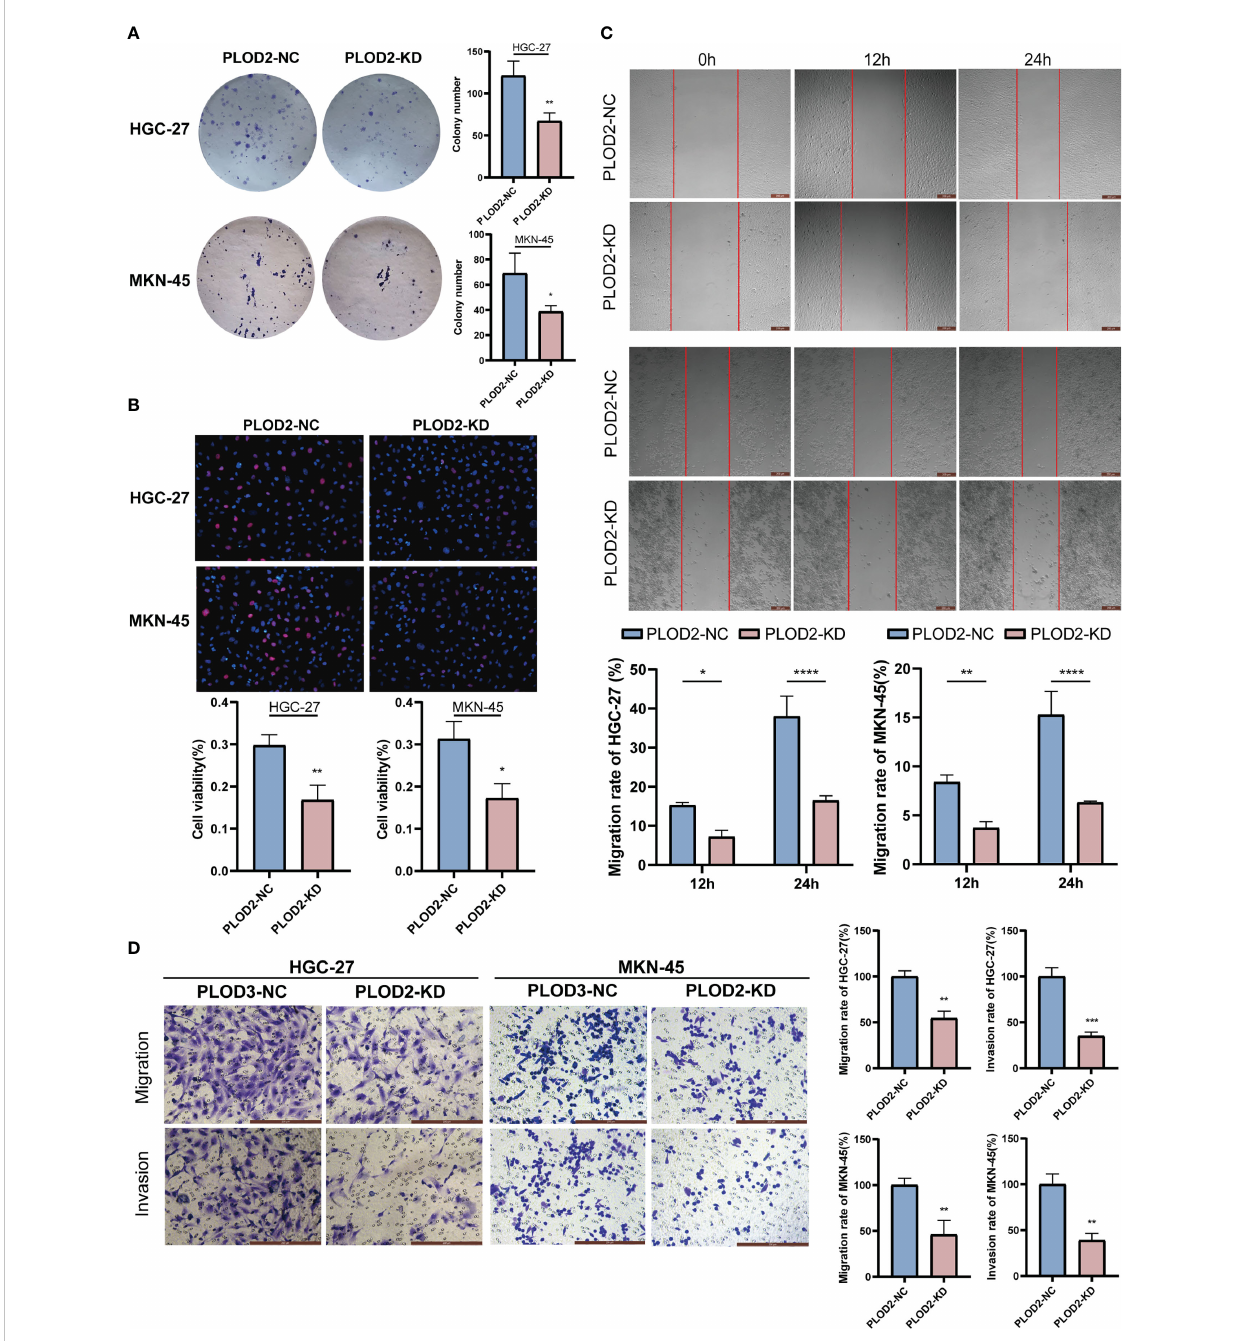
FIGURE 8 Vitro assay results of PLOD2 in gastric cancer cell.*p<0.05; **p<0.01; ***p<0.001; ****p<0.0001. Scale bar, 200 µm. (A) Plate cloning assay results of PLOD2 -NC and PLOD2-KD in HGC-27 and MKN-45 cells. (B) EdU assay results of PLOD2-NC and PLOD2-KD in HGC-27 and MKN-45 cells. (C) Wound-healing assay results of PLOD2-NC and PLOD2-KD in HGC-27 cells. (D) Transwell assay results of PLOD2-WT and PLOD2-KD in HGC-27 and MKN-45